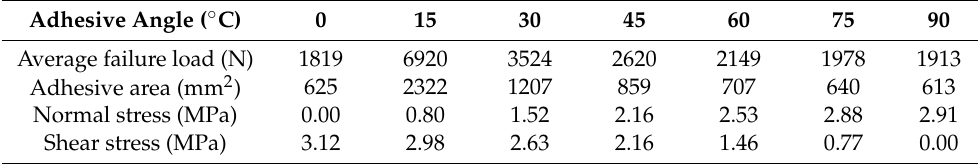
Table 6. Failure strength values of seven groups of adhesive specimens at different angles at 0 ◦ C. Adhesive Angle ( ◦